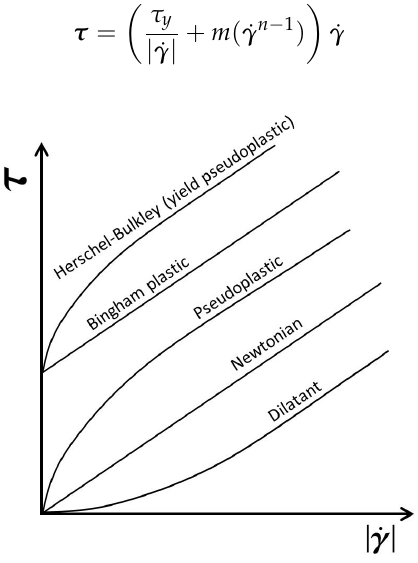
Figure 1. Rheograms of time-independent flow behaviour (adapted from